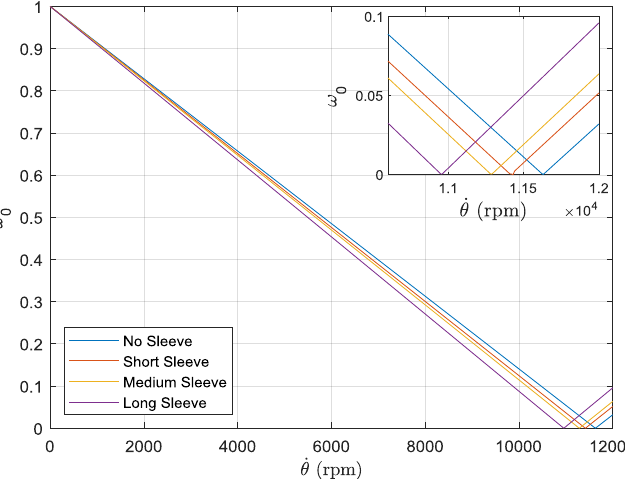
Figure 7. Campbell diagram for the full geometry finite element model. Inset shows natural frequencies and rotational velocity close to critical